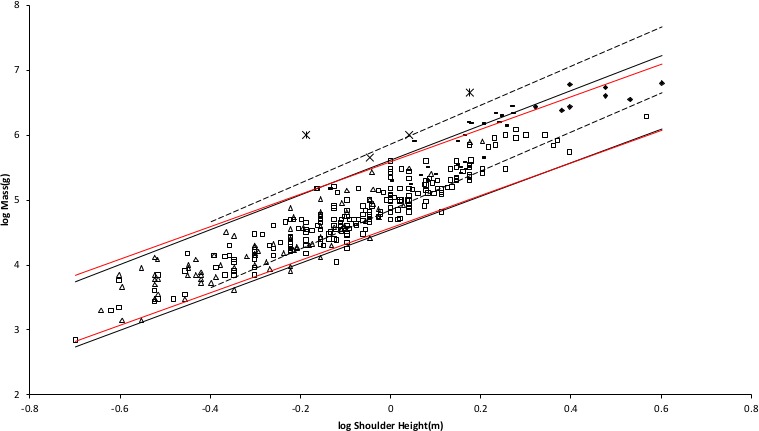
Log body mass as a function of log shoulder height for running/walking placental mammals.Data are from Nowak (1999). The solid and dashed lines are MMLE sturdiness factor boundaries. The upper boundaries were generated with a sturdiness factor s = (3)0.5. The lower boundaries were generated with s = (3)−0.5. The solid boundary lines are for Froude–Strouhal dynamic similarity. The black solid lines are for y = 2/3. The colored solid lines are for y = 0.8. The dashed boundary lines are for geometric similarity. The colored boundary lines, the geometric similarity boundary lines and the Perissodactyla and Proboscidea mass, shoulder height data have been added to the artiodactyl and carnivoran data displayed in Fig. 1. For Artiodactyla and Carnivora \documentclass[12pt]{minimal}
\usepackage{amsmath}
\usepackage{wasysym}
\usepackage{amsfonts}
\usepackage{amssymb}
\usepackage{amsbsy}
\usepackage{upgreek}
\usepackage{mathrsfs}
\setlength{\oddsidemargin}{-69pt}
\begin{document}
}{}${R}_{M}^{2}=0.9997$\end{document}RM2=0.9997 with respect to the solid black boundaries and \documentclass[12pt]{minimal}
\usepackage{amsmath}
\usepackage{wasysym}
\usepackage{amsfonts}
\usepackage{amssymb}
\usepackage{amsbsy}
\usepackage{upgreek}
\usepackage{mathrsfs}
\setlength{\oddsidemargin}{-69pt}
\begin{document}
}{}${R}_{M}^{2}=0.9992$\end{document}RM2=0.9992 with respect to the colored boundaries. For Perissodactyla and Proboscidea \documentclass[12pt]{minimal}
\usepackage{amsmath}
\usepackage{wasysym}
\usepackage{amsfonts}
\usepackage{amssymb}
\usepackage{amsbsy}
\usepackage{upgreek}
\usepackage{mathrsfs}
\setlength{\oddsidemargin}{-69pt}
\begin{document}
}{}${R}_{M}^{2}=1.0$\end{document}RM2=1.0 with respect to the geometric similarity boundaries. Perissodactyls are marked with solid rectangles. Proboscideans are marked with solid diamonds. Aritiodactyla data are marked with open squares. Carnivora data are marked with open triangles. Crossed Xes mark Hippopotamus amphibious. Xes mark domestic cattle.